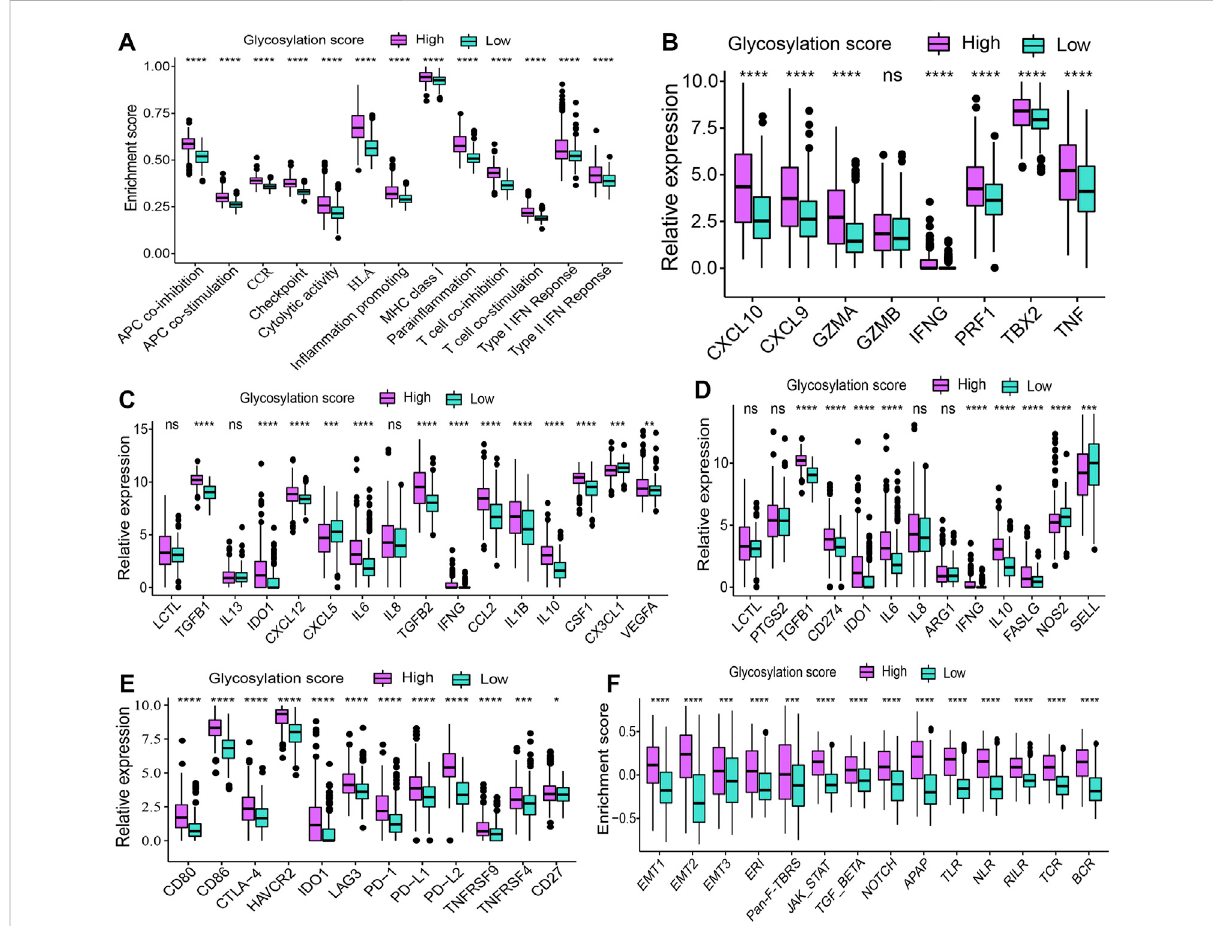
FIGURE 7 Cytokine, chemokine, and other related biological processes in glycosylation score subgroups. (* p < 0.05; ** p < 0.01; *** p < 0.001; **** p < 0.0001;ns,notsigni fi cant) (A) Differenceintheenrichmentscoreofimmunefunctionsbetweenglycosylationscoresubgroups. (B) Differenceinthe gene expression related to immune activation between glycosylation score subgroups. The difference in the expression of (C) immunosuppressive cell recruitment factors and (D) immunosuppressive factors between glycosylation score subgroups. (E) Difference in the gene expression related to immune checkpoints between glycosylation score subgroups. (F) Difference in the gene expression of other related biological processes including immune activation, stromal activation, and cancer promotion between glycosylation score subgroups. ERI, extracellular matrix (ECM) receptorinteraction;Pan-F-TBRS,pan- fi broblastTGFbresponsesignature;APAP,antigenprocessingandpresentation;TLR,Toll-likereceptor;NLR, NOD-like receptor; RILR, RIG-I-like receptor; TCR, T cell receptor; BCR, B cell